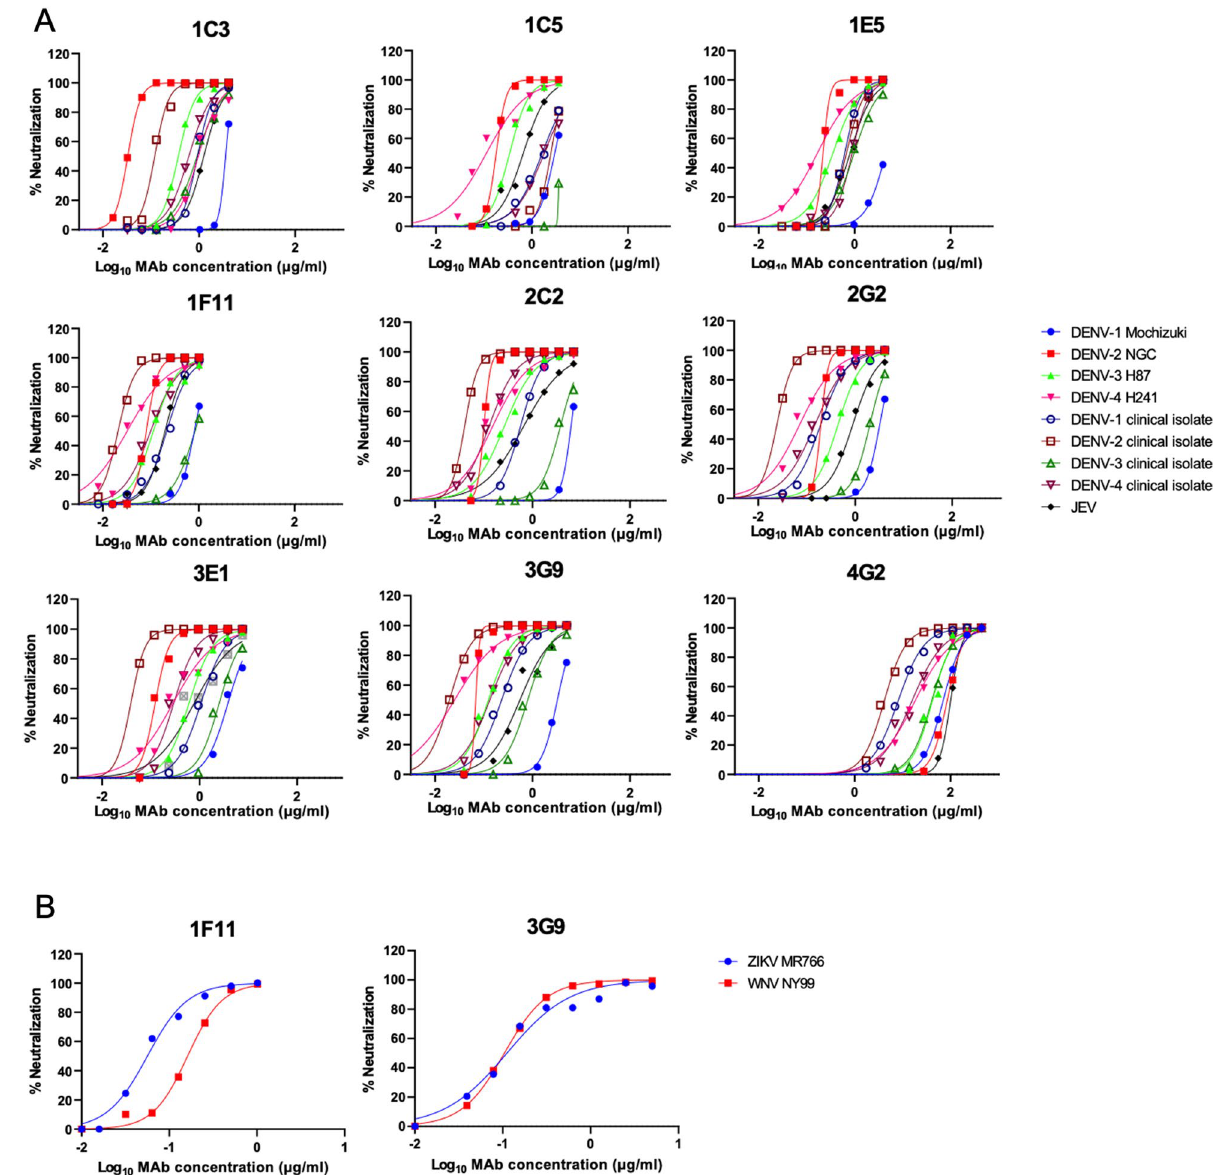
Figure 1. Neutralization of DENV, JEV, WNV, and ZIKV. ( A ) Neutralizing activity against DENVs and JEV. ( B ) Neutralizing activity against SRIPs containing prM-E of WNV and ZIKV. Average of two independent experiments is